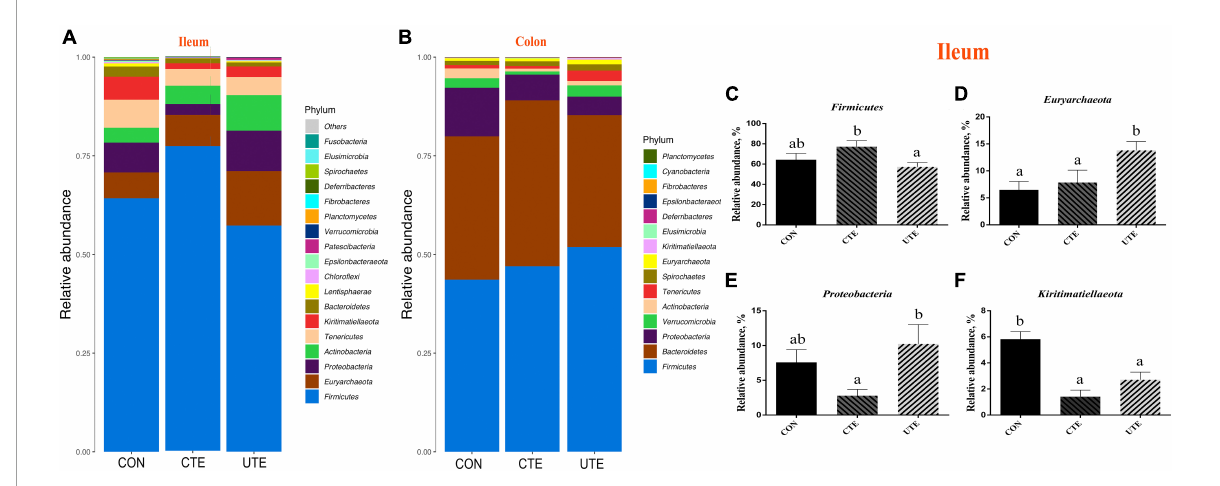
FIGURE6 Effects of coated and uncoated trace elements on the relative abundance of bacteria at phylum level. (A) The bacterial composition at phylum level in the ileum; (B) the bacterial composition at phylum level in the colon; (C–F) bacteria with differences in abundance in the ileum at the phylum level. CON, sheep fed with the basal diets; CTE, sheep fed with the basal diets plus 400 mg/kg coated trace elements; UTE, sheep fed with the basal diets plus an equal amount of trace elements in uncoated form. Data are represented as mean and standard error and with different small letter superscripts mean significantly different ( P < 0.05), n = 4.